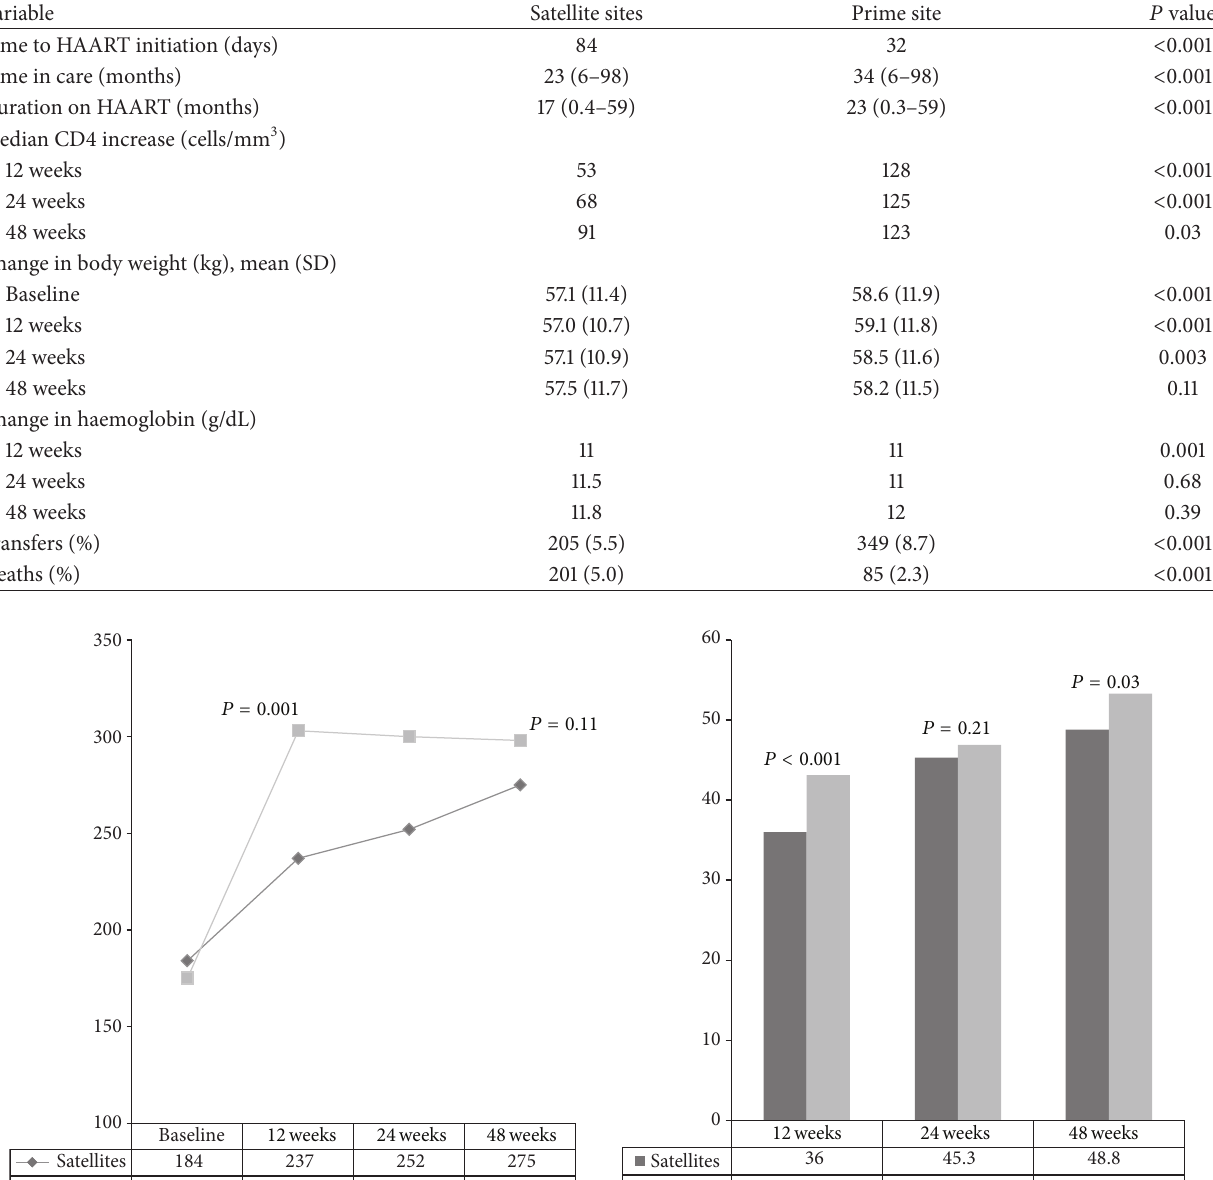
Table3:Outcomesthrough12monthsoffollow-upamongpatientsinitiatingantiretroviraltherapyinadecentralizedHIVtreatmentprogram